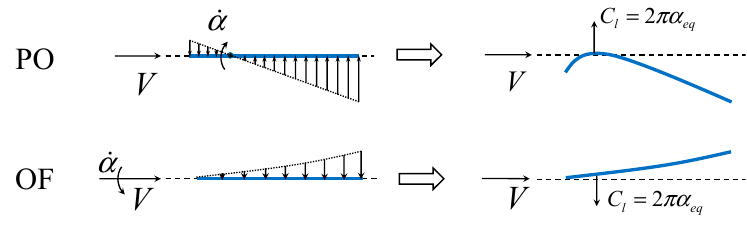
Figure 2. Induced effective camber for pitch oscillation (PO, upper) and oscillating freestream (OF, lower).